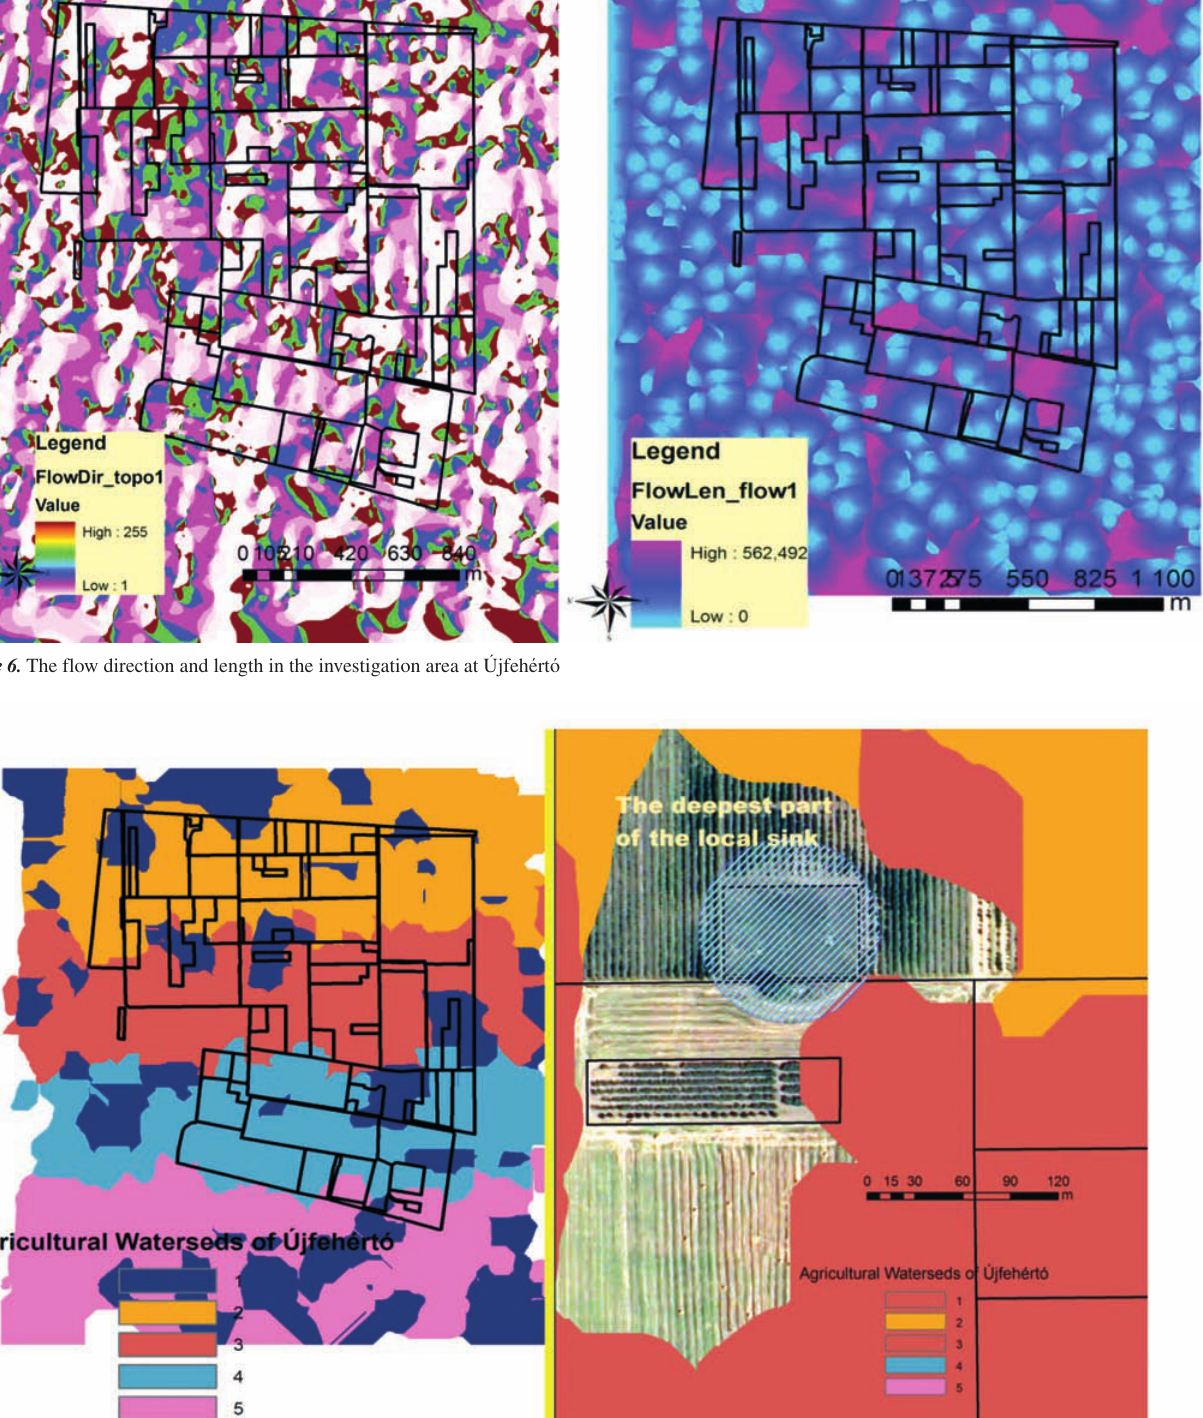
Figure 7. Small water catchments in the investigation area; The deepest sink of the